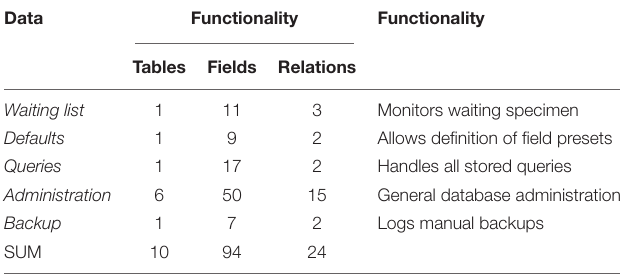
TABLE 3 | Data structure overview (part 3): tables related to database